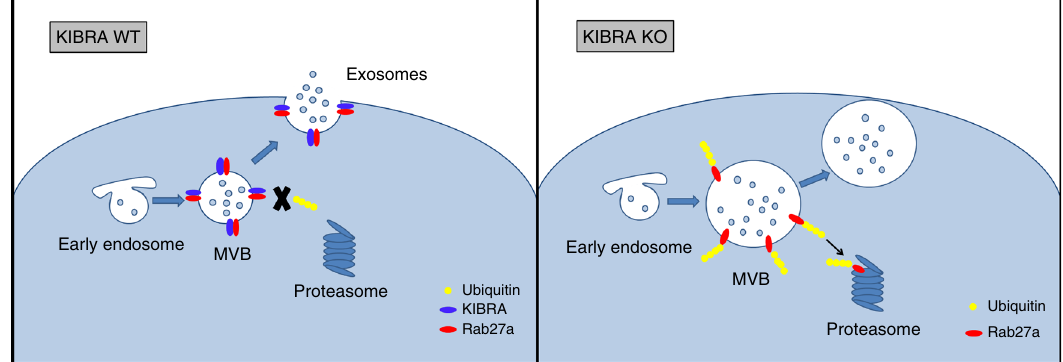
Fig. 7 A schematic representation of a model for the role of KIBRA in the regulation of exosome secretion. KIBRA stabilizes Rab27a and keeps it from being ubiquitinated. Depleting KIBRA increased Rab27a proteasomal degradation, thus inhibiting exosome